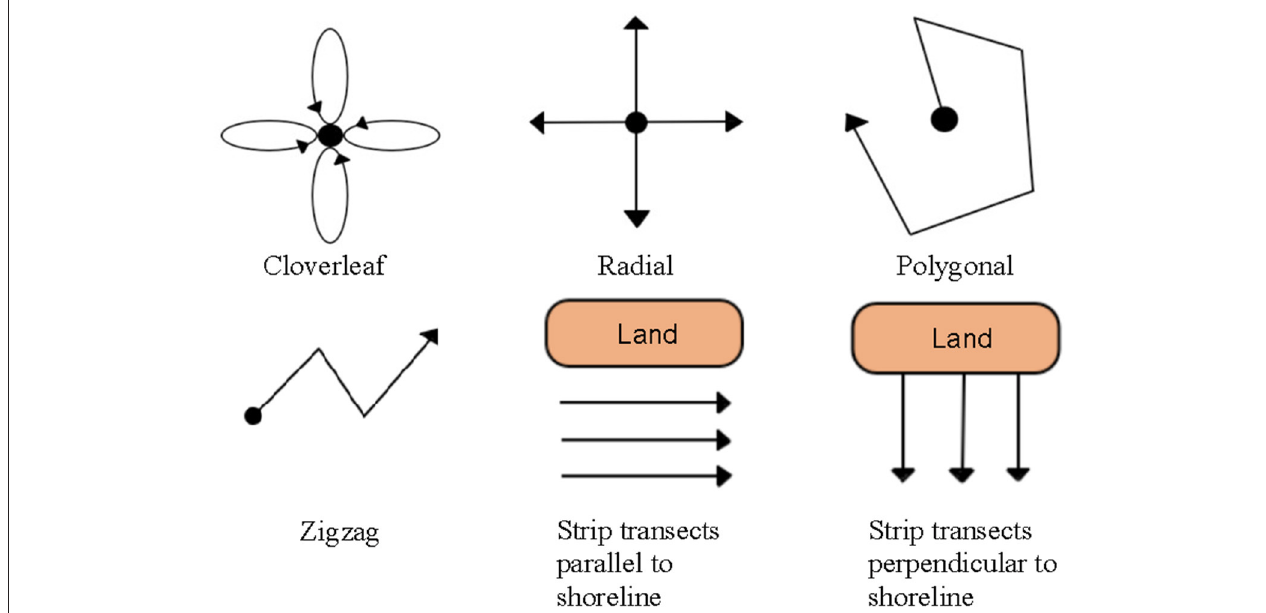
FIGURE 7 | Different transect designs available for visual surveys of fish assemblages using